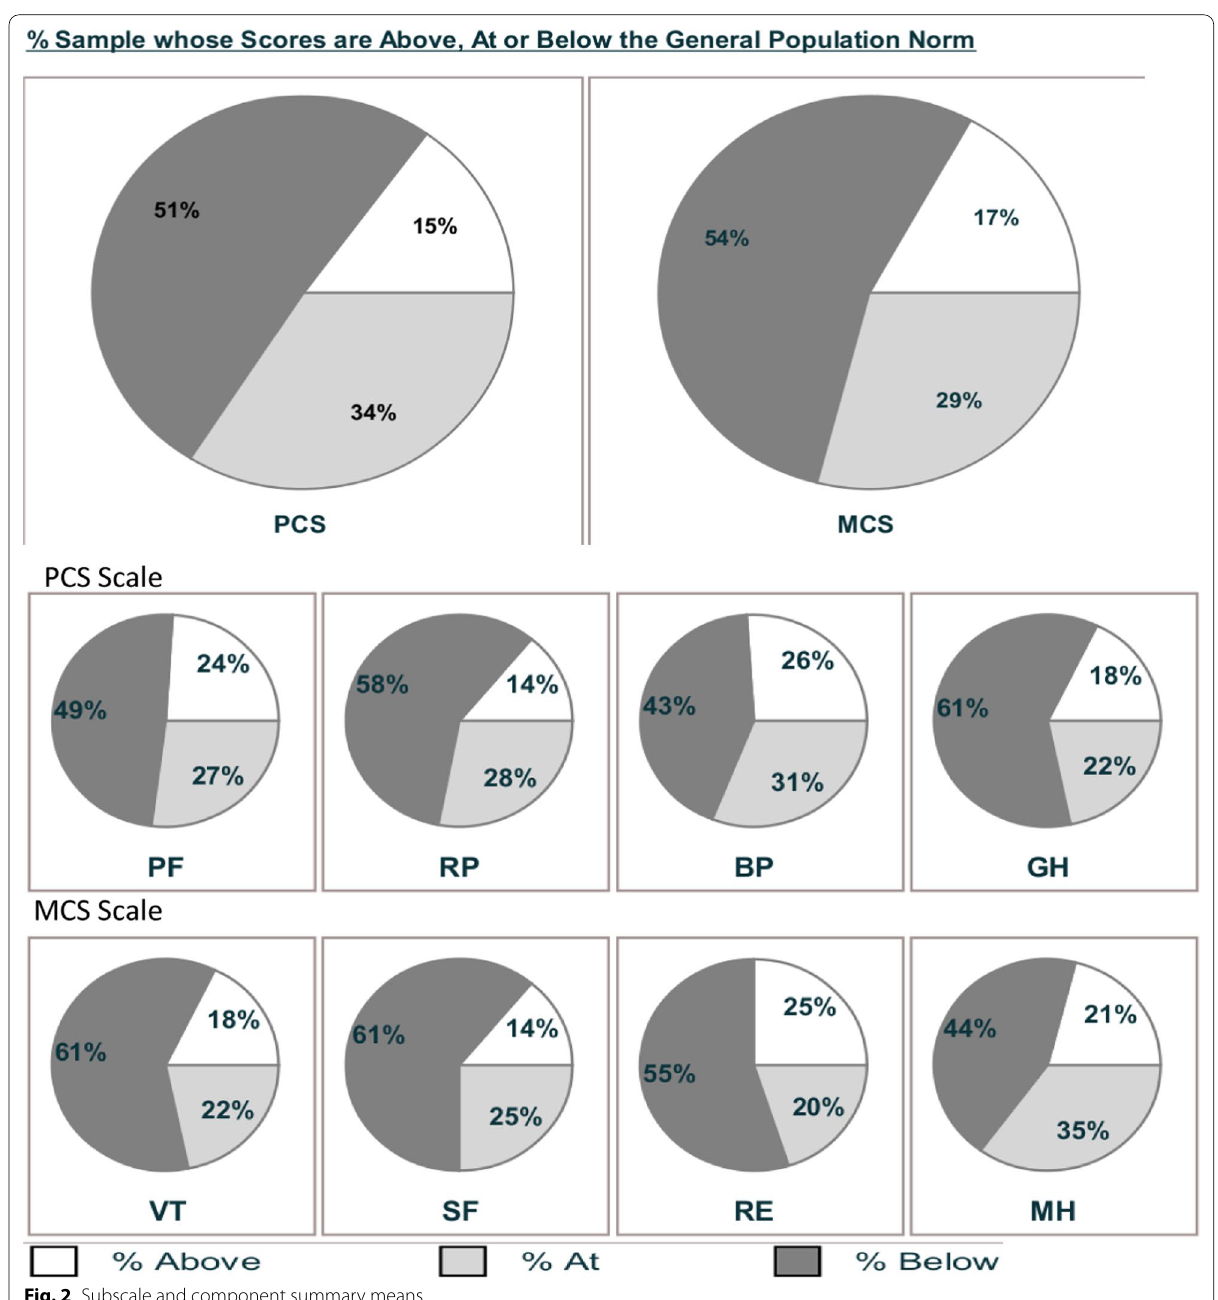
Fig. 2 Subscale and component summary